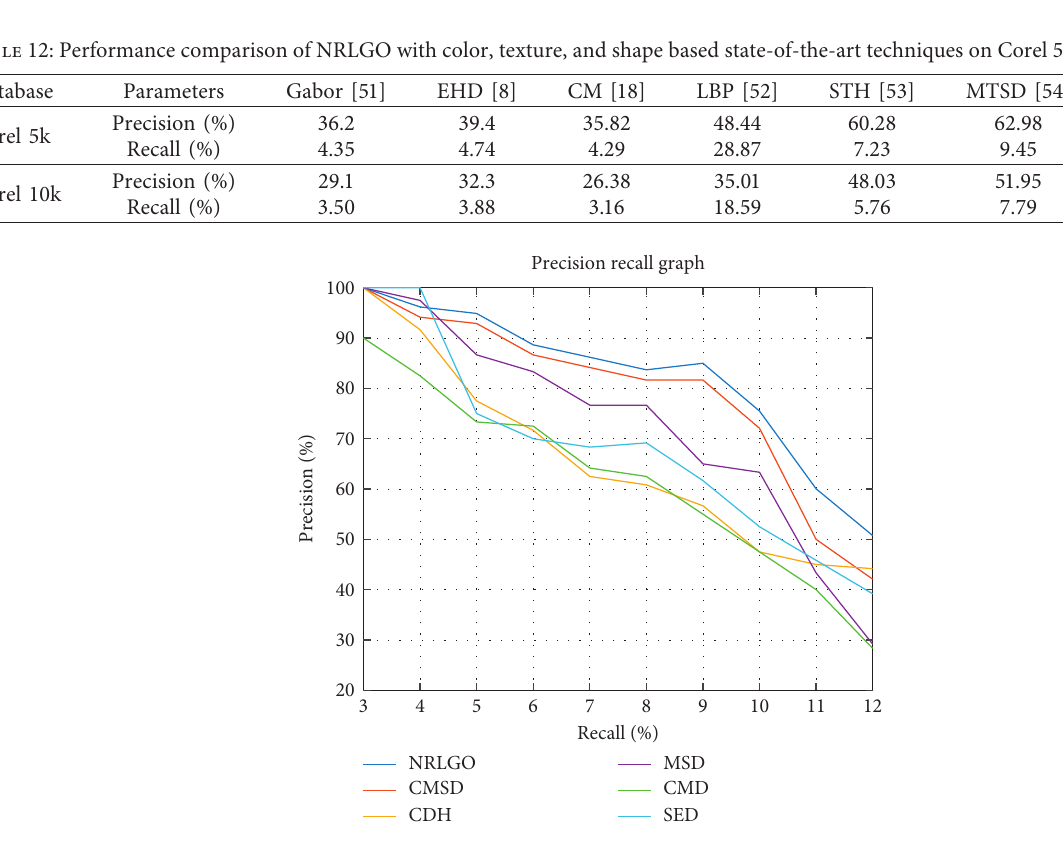
Figure 6: Performance of NRLGO is compared with state-of-the-art descriptors on Corel 1k using precision and recall parameter.